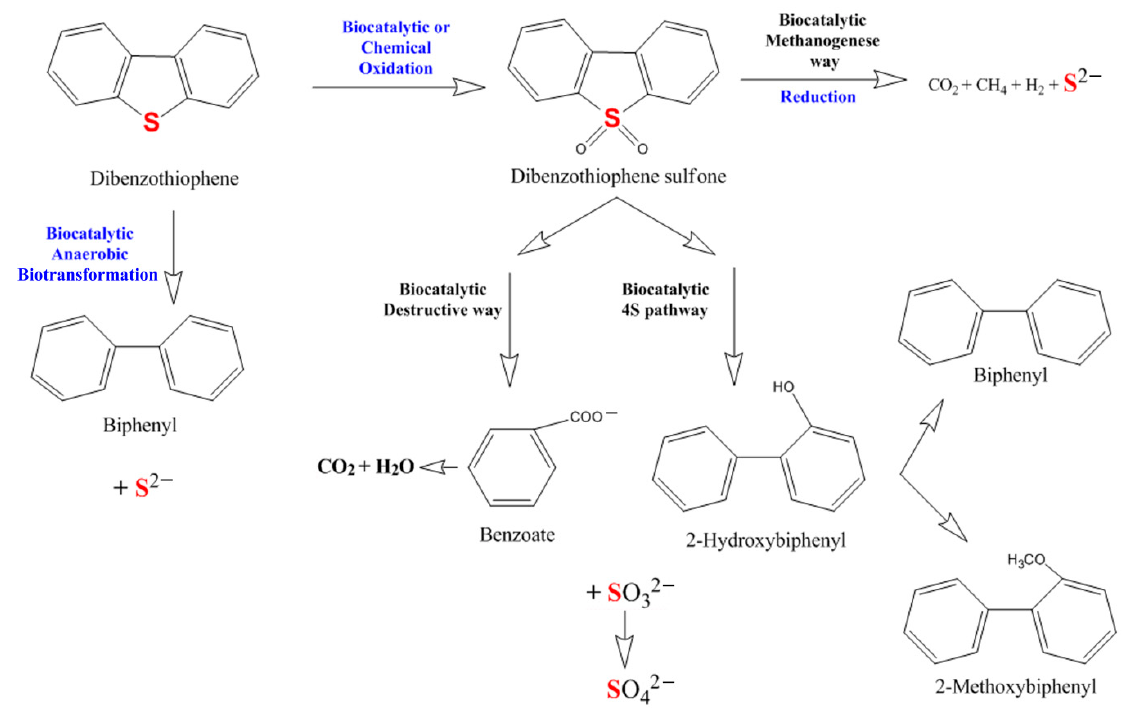
Figure 1. Possible pathways for transformation of DBT and its sulfone (DBTO 2 ) in the presence of BCs. Other pathways for biotransformation of sulfones are also known, such as destruc ‐